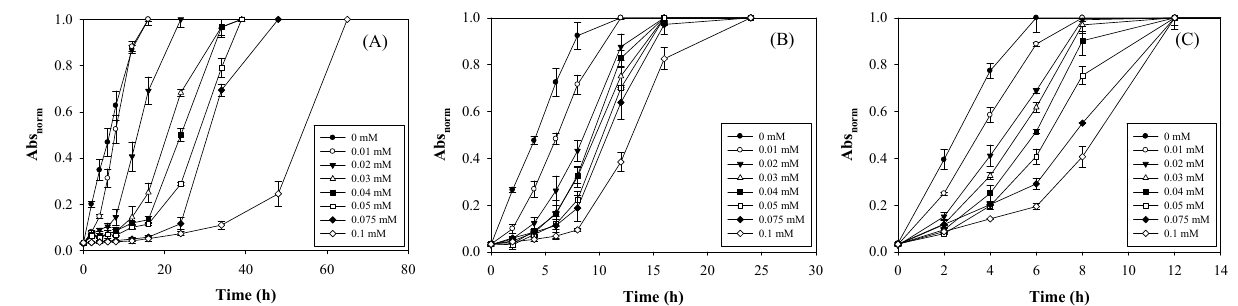
Figure 4. Abs norm changes of a TTI prototype with immobilized laccase of 20 μ g/cm 2 and 0–0.10 mM N-HGG under ( A ) 15, ( B ) 25, ( C ) and 35 °C.